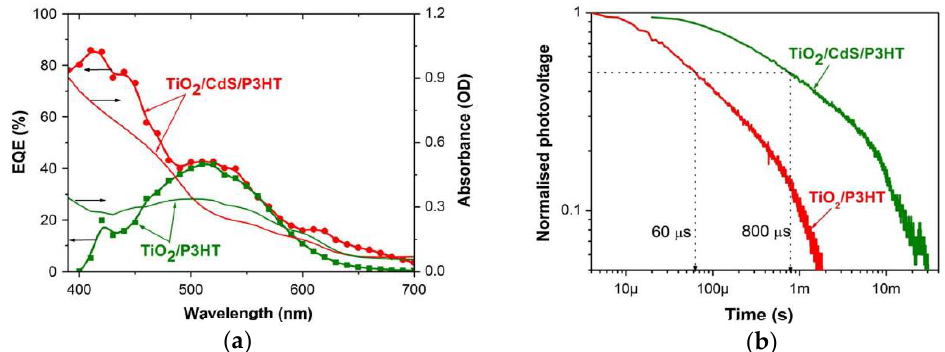
Figure 5. ( a ) External quantum efficiency and absorbance spectra of CdS incorporated TiO 2 /P3HT solar cells and nanostructured films, respectively. ( b ) Double logarithmic normalized photovoltaic transient decay of TiO 2 /P3HT solar cells with and without CdS [79].